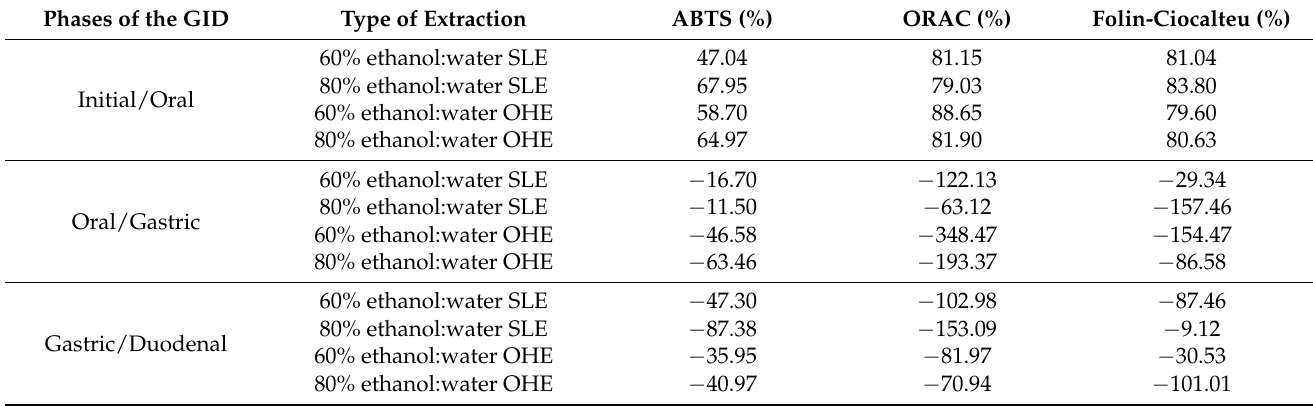
Table 3. Percentages of differences between the different phases of the gastrointestinal tract (GID) simulation of brewer’s spent grain (BSG)